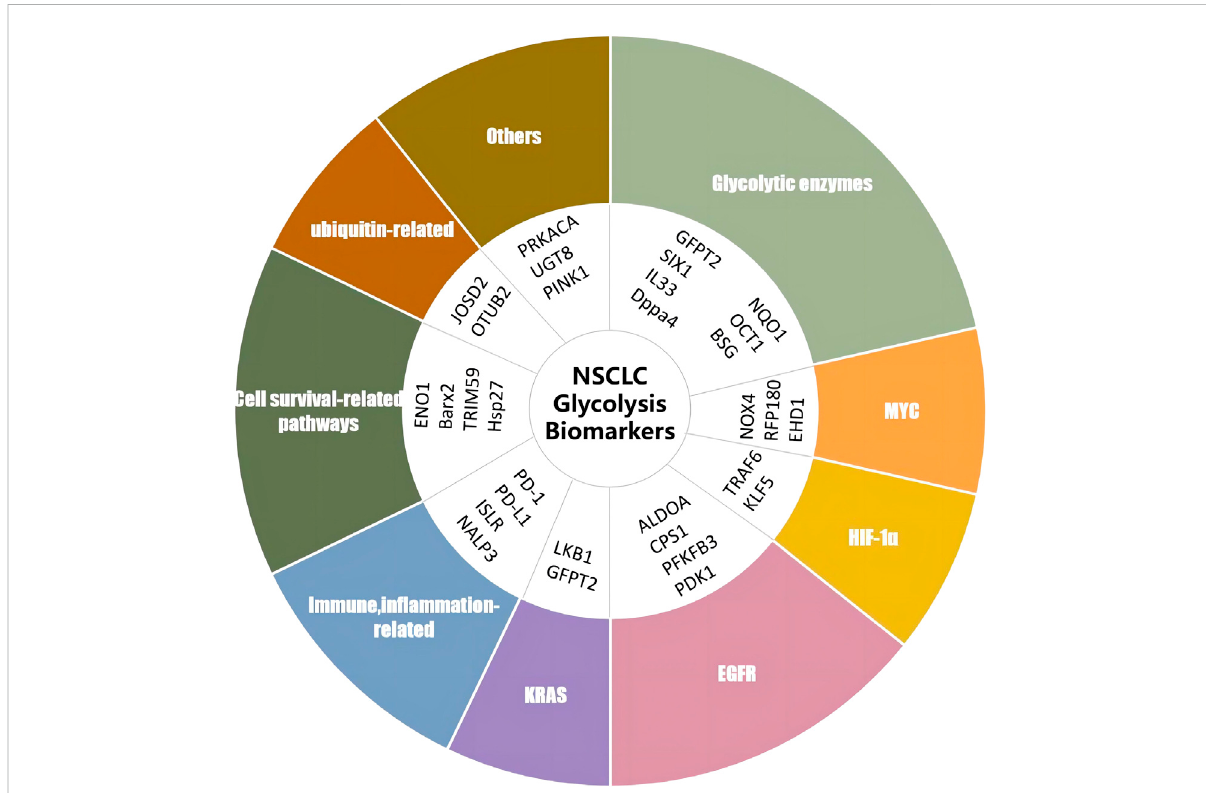
FIGURE 2 Biomarkers of glycolysis in NSCLC. RNF180, ring fi nger protein 180; UGT8, UDP-glycosyltransferase 8; SIX1, sine oculis homeobox homolog 1; TRAF6, TNF receptor-associated factor 6; EHD1, Eps15 homology domain 1; OCT-1, octamer-transcription factor-1; ISLR, leucine-rich repeat; JOSD2, Josephin domain containing 2; PRKACA, protein kinase cAMP-activated catalytic subunit alpha; PFKP, phosphofructokinase; TRIM59, tripartite motif-containing 59; NALP3, NLR family pyrin domain containing 3; CPS1, carbamoyl phosphate synthetase I; PFKFB3, 6- phosphofructo-2-kinase/fructose-2,6-bisphosphatase; PD-1, programmed cell death protein 1; PD-l1, programmed death-ligand 1; OTUB2, OTU deubiquitinase,ubiquitinaldehydebinding2;DPPA4,developmentalpluripotency-associated4;PINK1,PTEN-inducedputativekinase1;KLF5,factor 5; ALDOA, aldolase A; EGFR, epidermal growth factor receptor; GFPT2, glutamine-fructose-6-phosphate transaminase 2; NQO1, NAD(P)H quinone oxidoreductase 1; PDK1, pyruvate dehydrogenase kinase 1; BARX2, BarH-like homeobox2; PGC-1alpha, pPARG coactivator 1 alpha; NOX4, NADPH oxidase 4; IL-33, interleukin 33; ENO1, alpha-enolase; BSG, cD147/basigin; KRAS, Kirsten-RAS; GAPDH, glyceraldehyde-3-phosphate dehydrogenase; FBP1, fructose-1,6-bisphosphatase; HIF-1 α , hypoxia-inducible factor 1 subunit alpha; Hsp27, heat shock protein